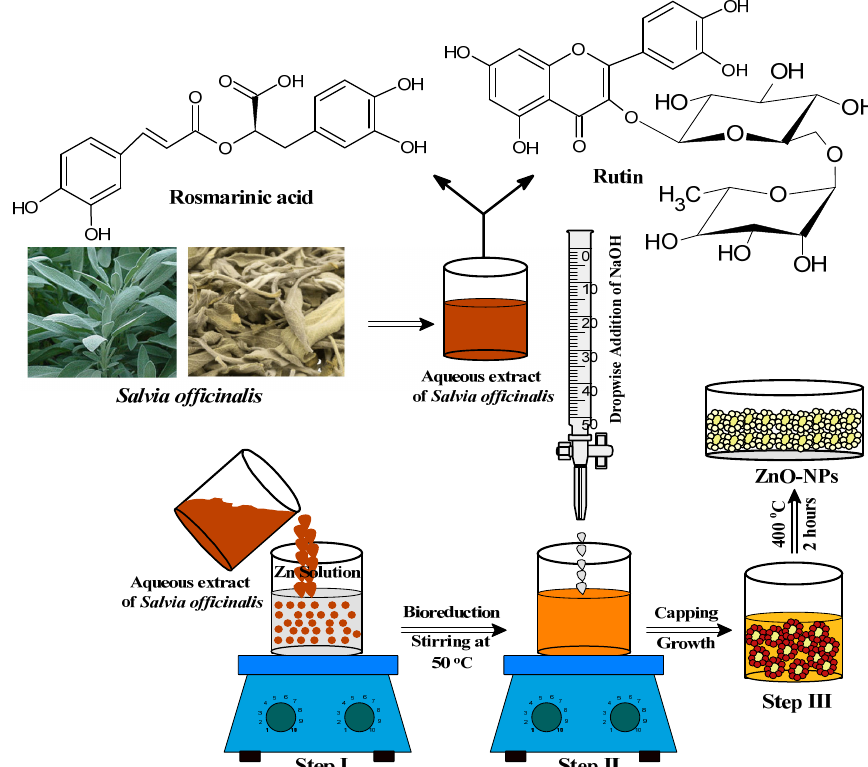
Figure 1. Schematic representation for the bio ‐ fabrication of ZnONPs.